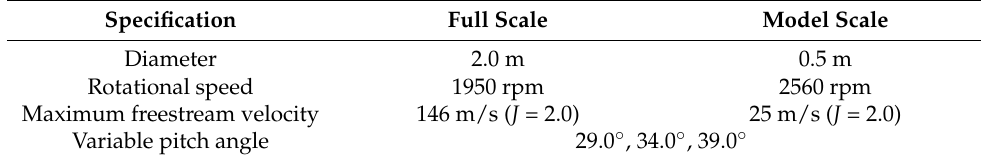
Table 1. The specifications of the target